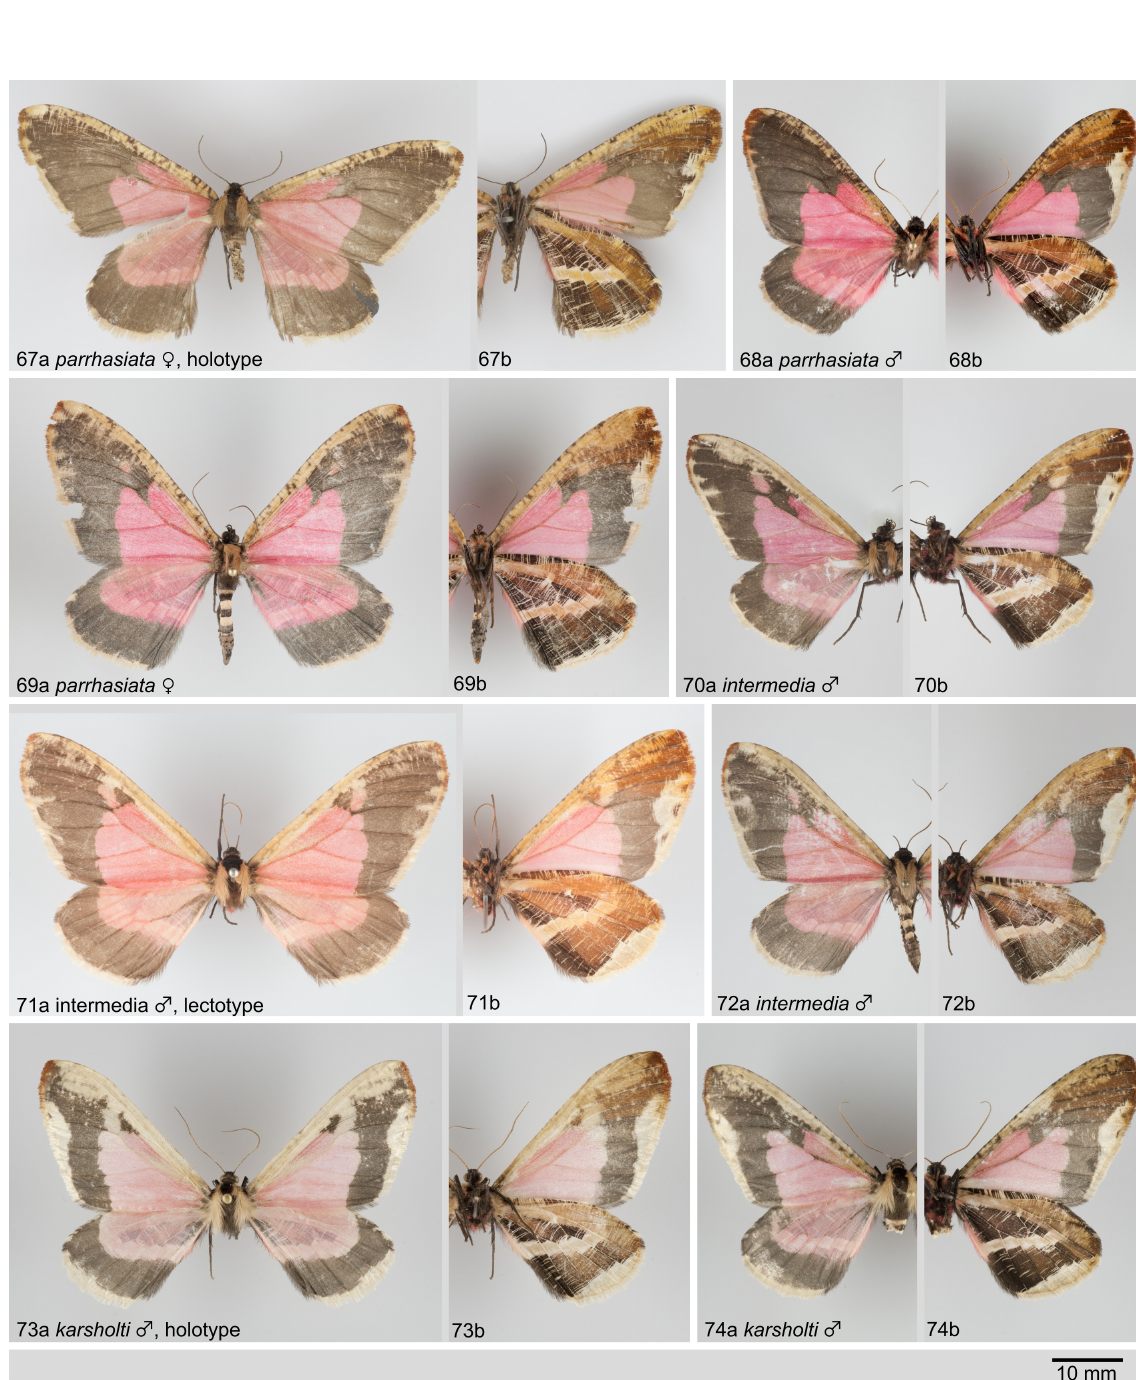
Figs 67–74. Adult moths (a = dorsal view; b = ventral view). 67 . Callipia parrhasiata Guenée, 1858, ♀, holotype (NHM). 68 . C. parrhasiata Guenée, 1858, ♂ (C-0039, COI data). 69 . C. parrhasiata Guenée, 1858, ♀ (C-0431). 70 . C. intermedia Dognin, 1914 stat. rev., ♂ (C-0097). 71 . C. intermedia Dognin, 1914 stat. rev., ♂, lectotype (C-0327). 72 . C. intermedia Dognin, 1914 stat. rev., ♂ (C-0031, COI data). 73 . C. karsholti sp. nov., ♂, holotype (C-0033, COI data). 74 . C. karsholti sp. nov., ♂ (C-0349, COI